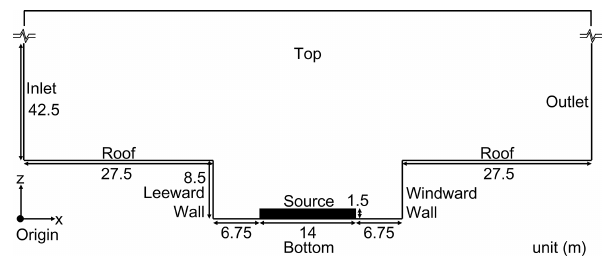
Figure 1. Simulation domain of street